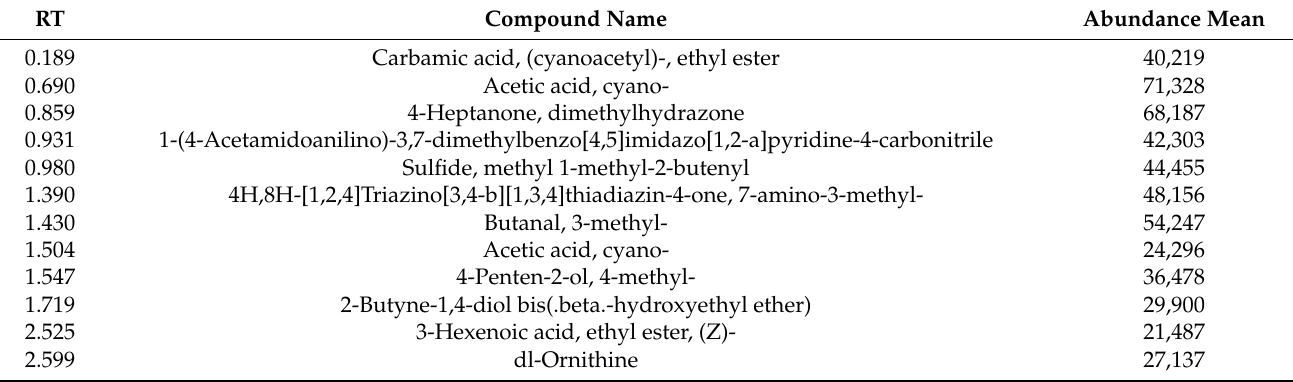
Table A6. Results for the EBP sample fingerprint determination with indication of the retention time (RT) and abundance mean for every identified